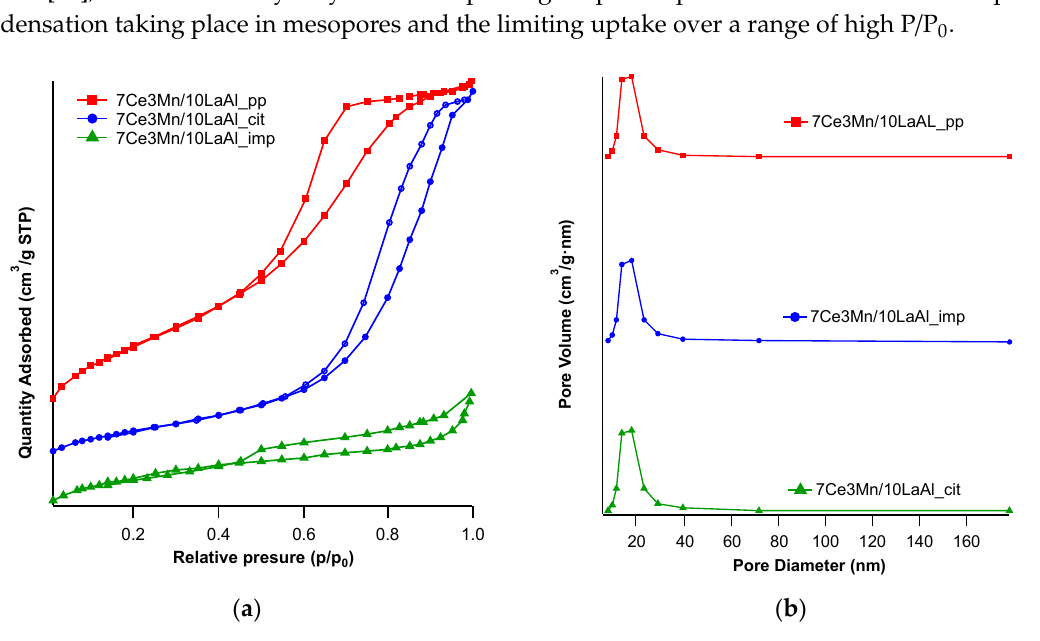
Figure 2. The setup for the evaluation of the catalytic properties of micro-converters exposed to CH 4 in synthetic air with 50% relative humidity.